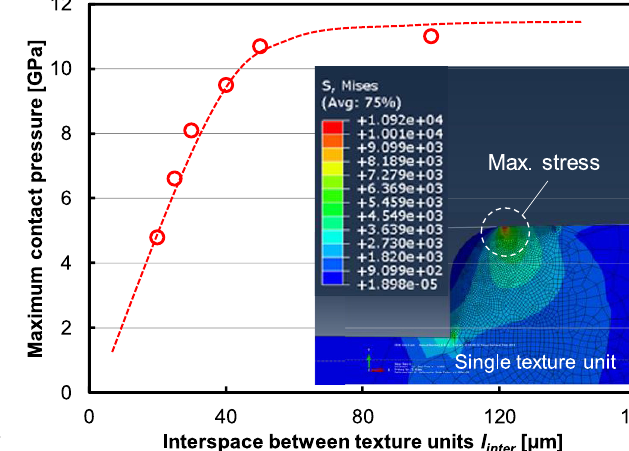
Fig. 11. Variation of maximum contact pressure as a function of interspace between texture units, obtained by FE simulation. Inset fi gure shows contour image of distribution of equivalent stress at DLC single